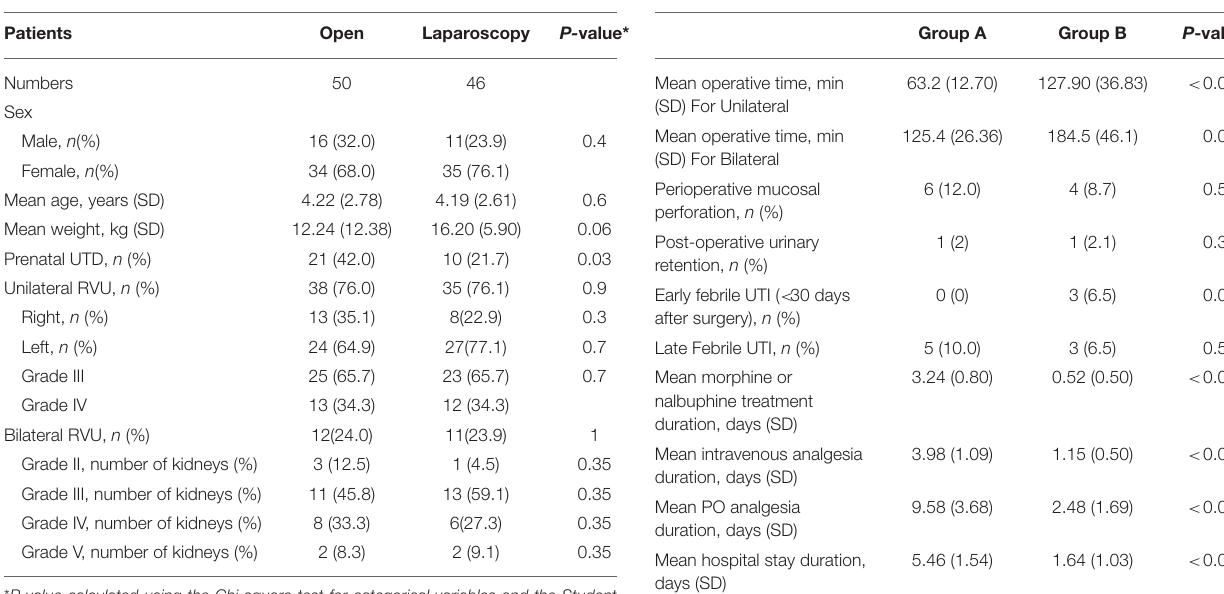
TABLE 1 | Patient and surgical demographics. TABLE 2 | Perioperative and postoperative